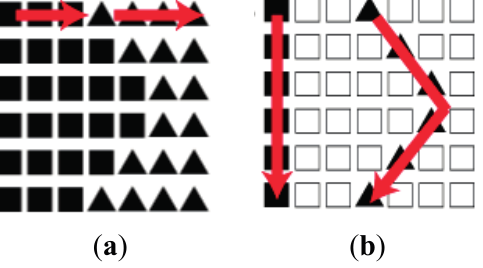
Figure 7. PIC format. ( a ) shows the original picture, ( b ) the right outlines the compression